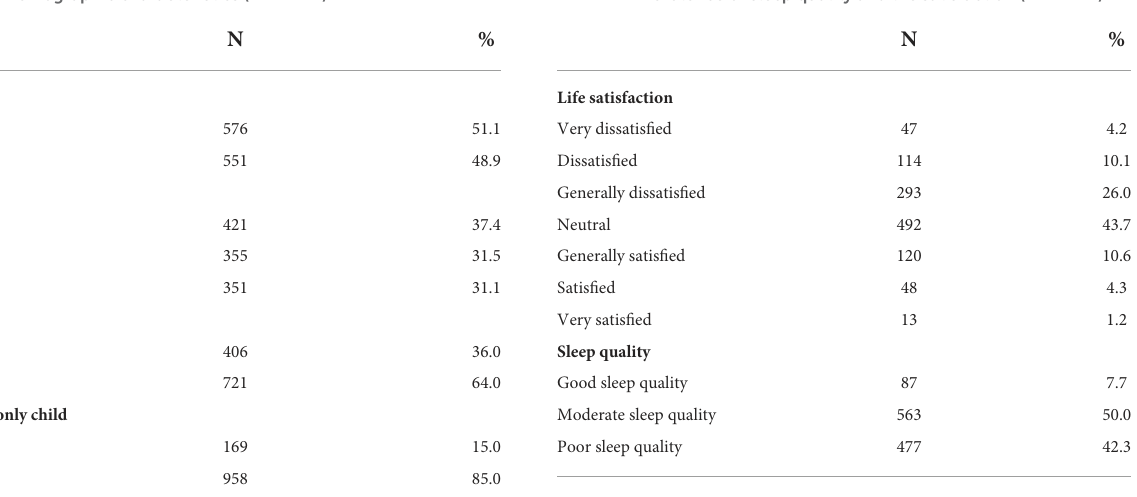
TABLE 1 Demographic characteristics ( n = 1127). TABLE 2 Prevalence of sleep quality and life satisfaction ( n =